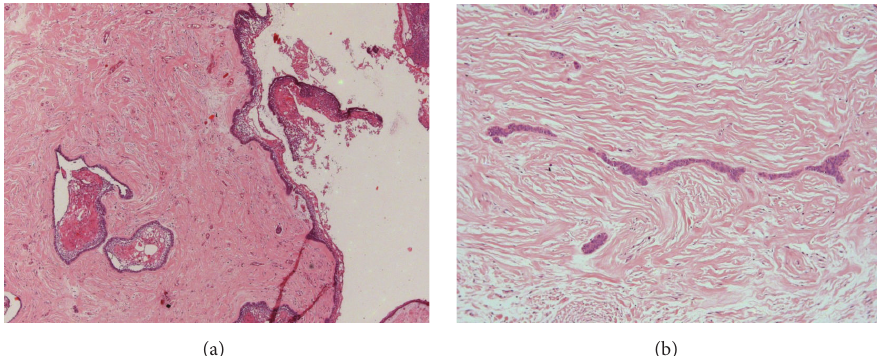
Figure 3: Microscopic characteristics. ((a) and (b)) Underlying the fibrous capsule, proliferation of neoplastic cells was noted, sometimes arranged in strands and sometimes in islands, with areas of squamous metaplasia, in addition to several islands of odontogenic epithelium (Hematoxylin and Eosin: (a) 25x; (b)